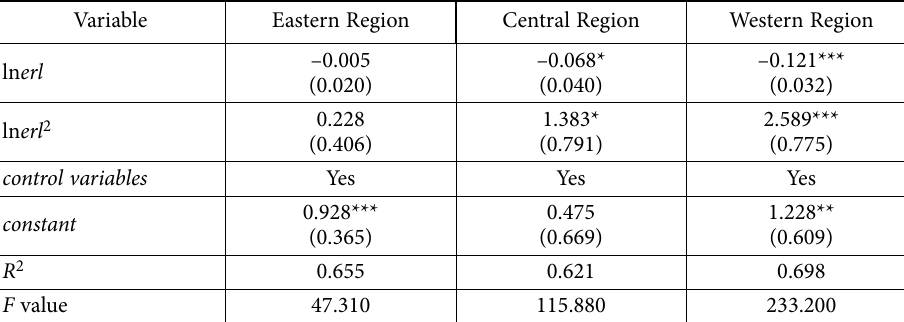
Table 6. Regression results of the impact of environmental regulation on environmental efficiency (source: The data in the table are calculated by the software of STATA)